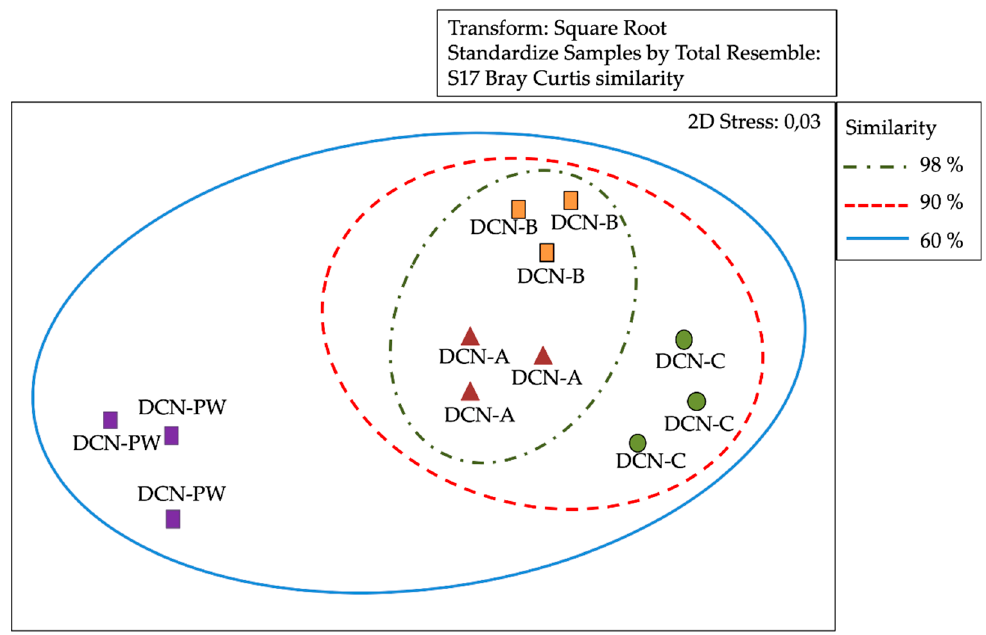
Figure 3. Multidimensional scaling (MDS) of the Denaturing Gradient Gel Electrophoresis (DGGE) data matrix of bacteria 16s rRNA from reverse osmosis (RO) membrane segments and potable water of north-central area dialysis centre (DCN). Similarly, index was evaluated for percentage. DCN-A: initial segment of DCN RO membrane. DCN-B: middle segment of DCN RO membrane. DCN-C: final segment of DCN RO membrane. DCN-PW: DCN potable water.